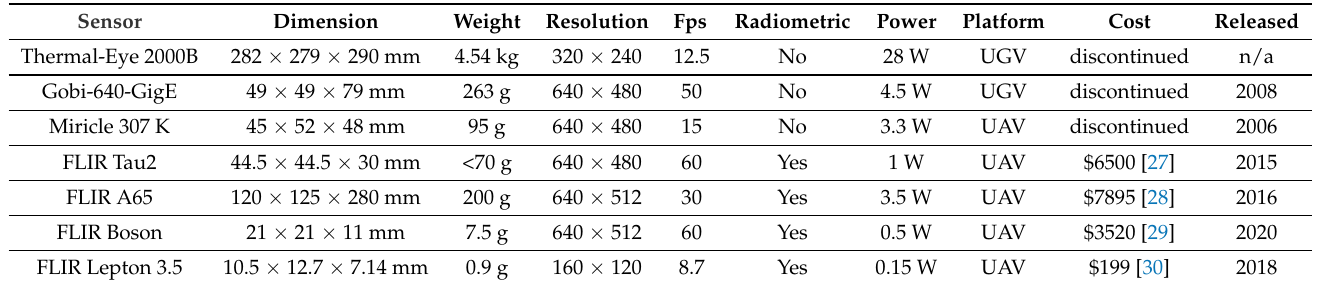
Table 1. Specifications of thermal sensors presented in this